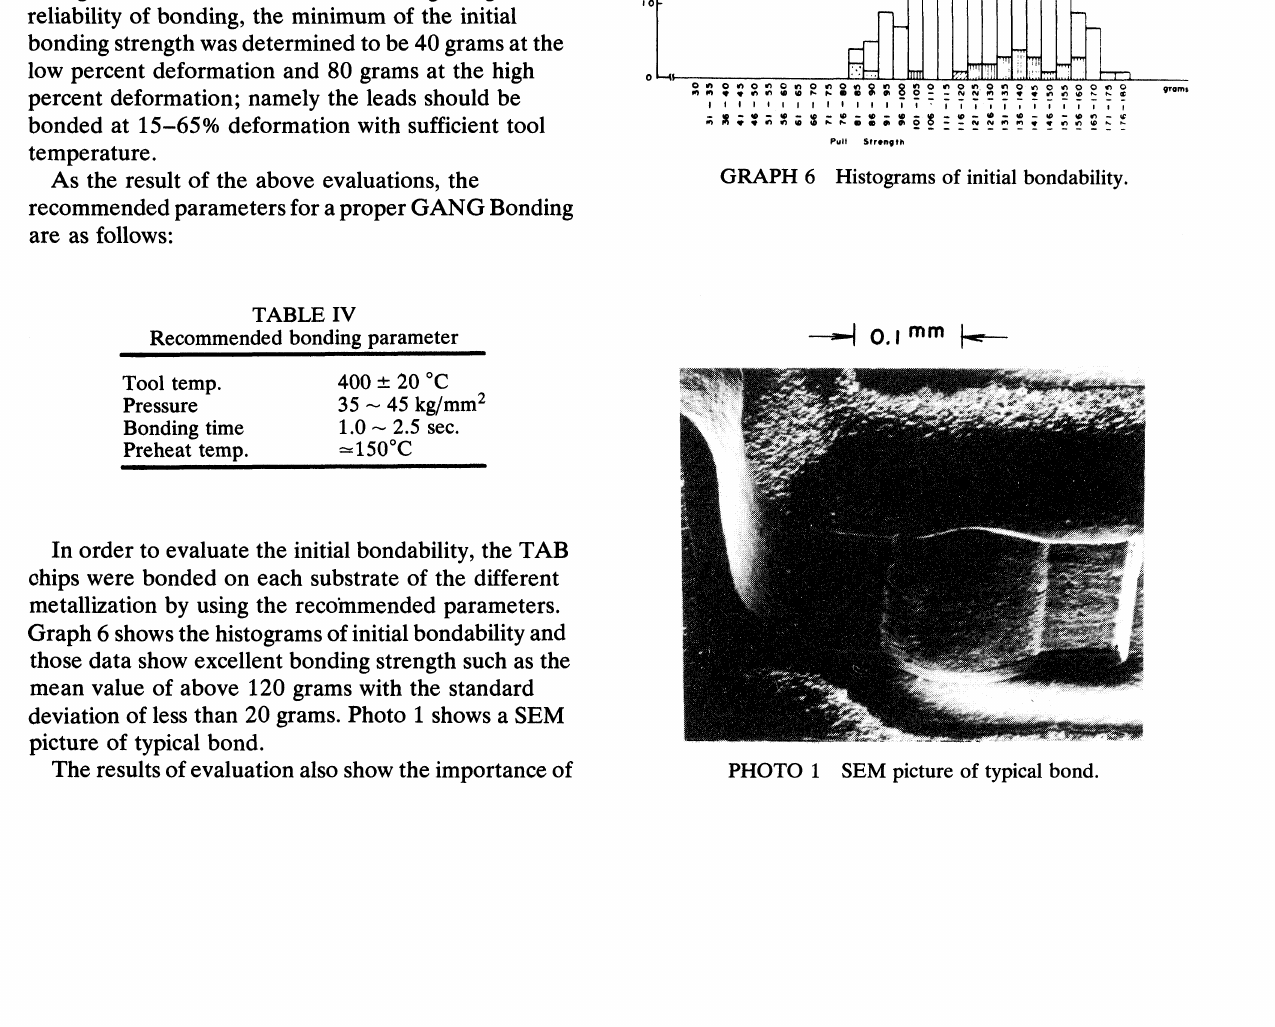
GRAPH 5 Relation between pull strength and lead deformation.